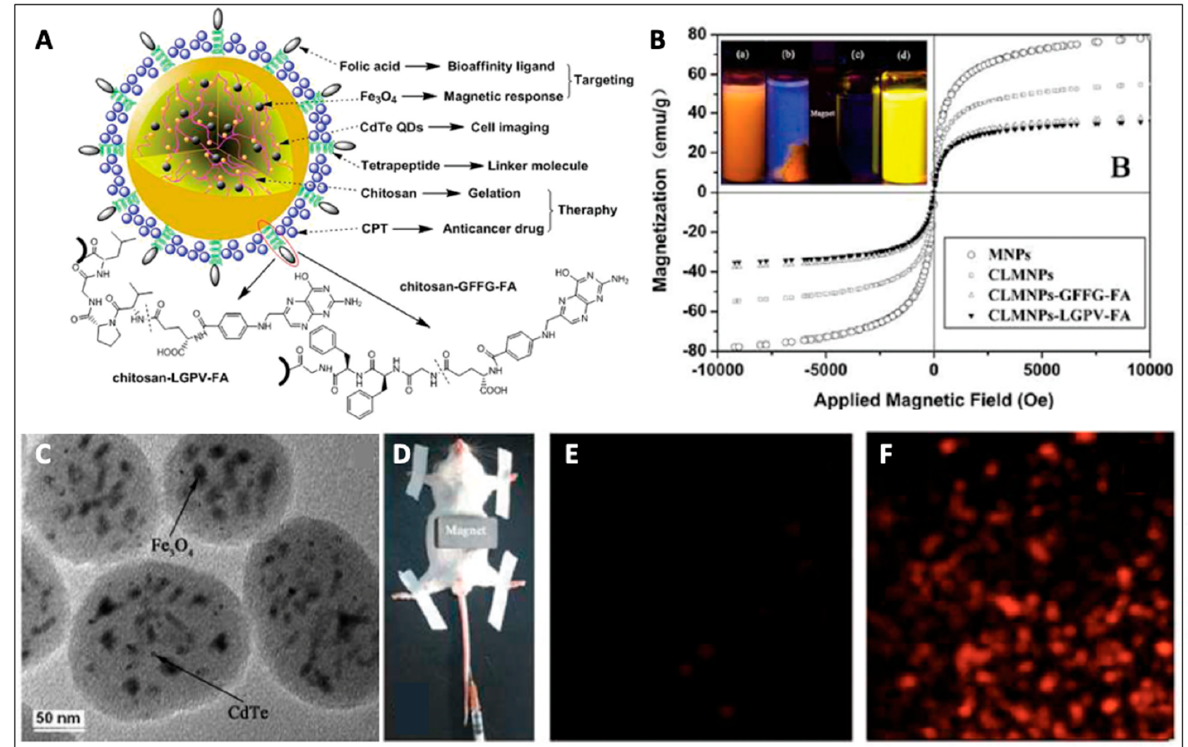
Figure 3. ( A ) Schematic diagram of chitosan-based luminescent and magnetic nanoparticles (CLM- NPs) with tetrapeptide (GFFG/LGPV) conjugated to folate; CLMNPs-tetrapeptide-FA composites. ( B ) VSM curves for Fe 3 O 4 NPs (MNPs), CLMNPs, CLMNPs-GFFG-FA, and CLMNPs-LGPV-FA at 305 K in an applied magnetic field. ( C ) TEM image of CLMNPs showing Fe 3 O 4 NPs and CdTe quan- tum dots in chitosan matrix. ( D ) Sarcoma-bearing Male S-180 Kunming mouse guided by a magnet after being injected with CLMNPs-GFFG-FA (200 μ g/mL in PBS) through the tail vein. ( E , F ) Fluo- rescence microscopy images ( λ exc = 488 nm, 10X) of tumor slices influenced without (E, control) and with (F) magnet. Reproduced with permission from Ref. [96]. Copyright 2012 American Chemical Society. The accumulation of magnetic nanoparticles with the help of a magnetic field is easier for targets that are closer to the surface. As the distance from the surface increases, it be- comes more difficult to maneuver the nanoparticles. Yellen et al. addressed this problem by inserting magnetic implants in the body of an organism near the target site [97]. An- other attempt was made to improve magnetic targeting in deep tissues by Pouponneau et al. Micro-carriers loaded with iron-cobalt nanoparticles and doxorubicin were adminis- tered to rabbits, and then they were kept inside an MRI scanner. The path towards the target site was pre-programmed, and the imaging gradient coils moved the nanoparticles around in the body. It was inferred that by employing the scanner, magnetic targeting was effective at any depth [98]. 5.2. Magnetic Hyperthermia Hyperthermia is heat generation that is used to heat the nearby cells and kill them. It can be used as a localized form of therapy which is gaining a lot of attention lately. Heat therapy is a highly effective treatment of cancer as tumor cells have a higher metabolic rate, and as a result, they are more sensitive to heat than normal cells [99]. When magnetic nanoparticles are exposed to an alternating magnetic field, energy is absorbed and then released in the form of heat by either hysteresis losses or relaxation mechanisms (Neel or Brownian) [100]. The heat generated depends upon the nanoparticle (size and